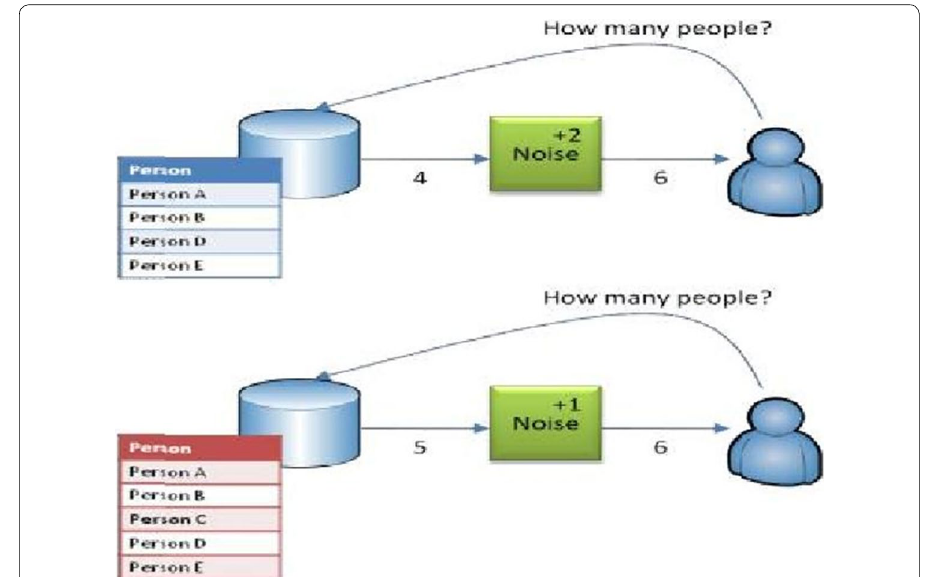
Fig. 2 Differential privacy through noise